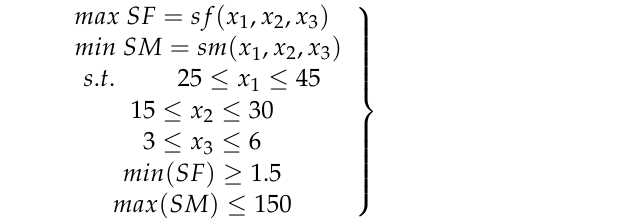
Table 5. Design factor coding and levels. Factor Variable